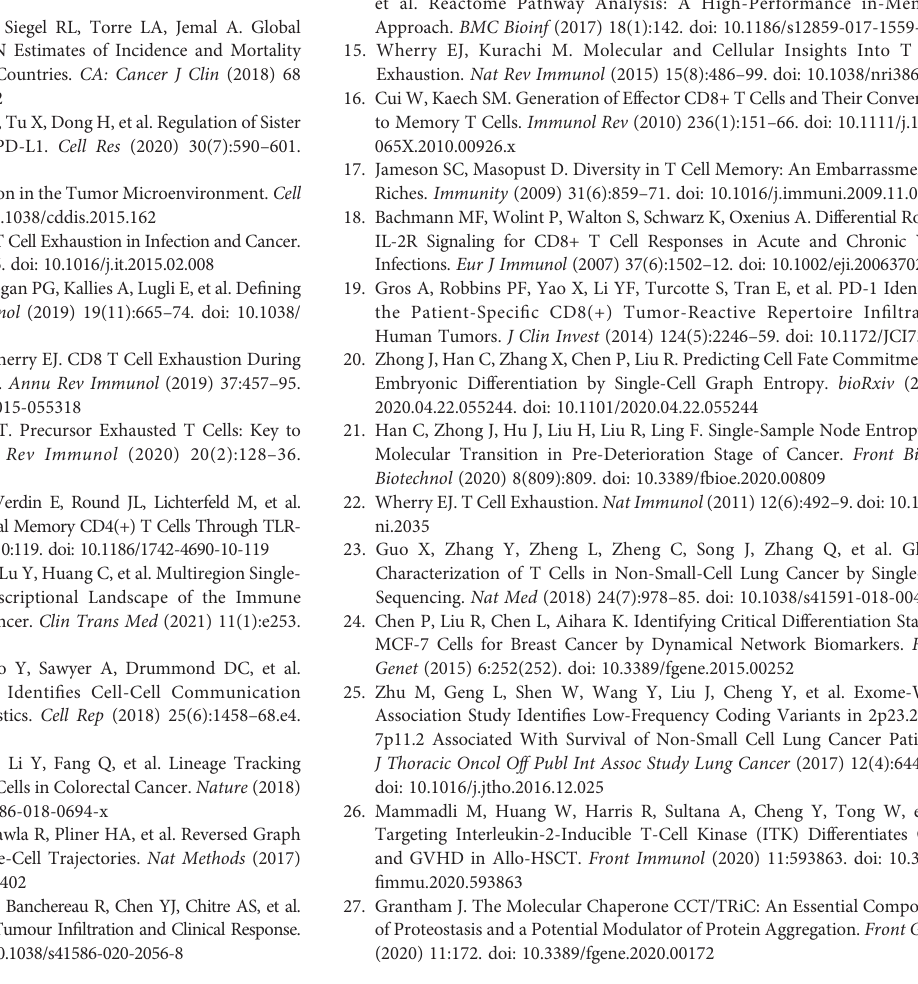
showing the dynamic expression changes of genes, including the function of T cell cytokine production, T cell apoptotic process, inhibitory receptors, cell proliferation and T cell effector function. Supplementary Figure 2 | GO enrichment results of DNB genes. (A) Pie chart representing the proportion of the top GO terms are ranked by the GO enrichment. (B) Shown is a Cytoscape visualization of the top GO terms interaction network. (C) Histogram showing the top GO terms ranked by GO enrichment. Supplementary Figure 3 | DNB genes drive the fl ipped expression of DEGs. (A) Pie chart representing the proportion of the top pathways of KEGG ranked by the KEGG enrichment. (B) The network plot shows the DNB genes interaction with DNB-neighboring DEG, including three T cell exhaustion periods. The network nodes from the purple region are DNB genes. The network nodes from the dark green region are DNB-neighboring-DEGs. The genes and their location in the network are the same for all three different exhaustion periods, and low to high gene expression is indicated by a gradation from green to red. (C) Gene expression heatmap showing gene expression of the CCT family and TUBA1B at different cancer stages and sources in TCGA COREAD dataset, and low to high gene expression is indicated by a gradation from blue to red. (D) Correlation of CCT6A and TUBA1B in TCGA COREAD dataset. The correlation coef fi cient (R) and signi fi cance of the correlation coef fi cient (P) were